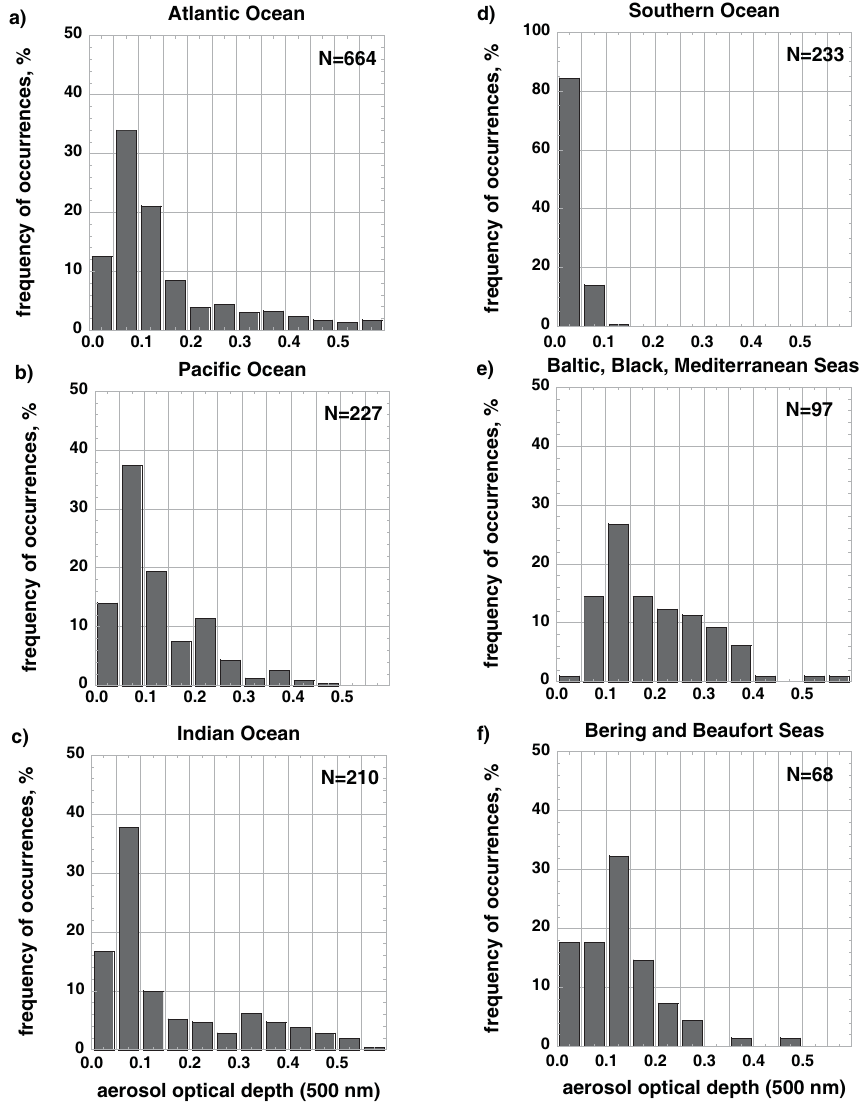
Fig. 4. Frequency of occurrences of daily averaged aerosol optical depth at 500nm for (a) Atlantic Ocean, (b) Pacific Ocean, (c) Indian Ocean, (d) Southern Ocean, (e) Baltic, Black, and Mediterranean Seas, (f) Bering and Beaufort